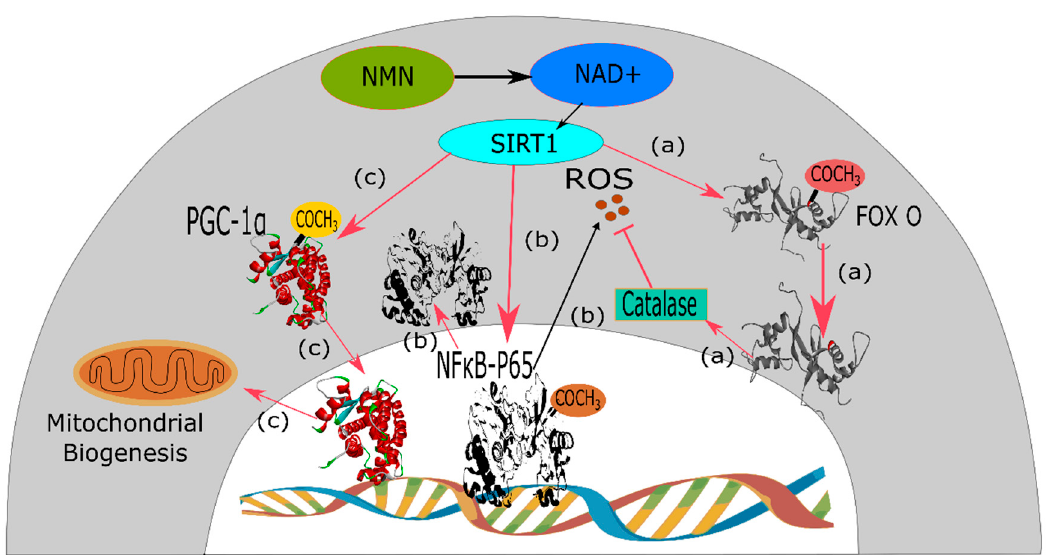
Figure 3. Mechanism of SIRT1 mediated pharmacological activities of NMN. NMN is converted to NAD+ intracellularly which performs physiological functions via SIRT1. ( a ) SIRT1 causes deacetylation of lysine residues of FOXO transcription factor that stimulates catalase enzyme to inhibit ROS and the chain reactions leading to ischemia-reperfusion injury. ( b ) In normal condition, p65 subunit of NF κ B transcription factor complex, in its acetylated form, expresses ROS which is also responsible for insulin resistance. SIRT1, due to its inherent deacetylation activity, deacetylates p65-NF κ B and thus inhibits production of ROS, which is responsible for the occurrence of type-2 diabetes mellitus. ( c ) SIRT1 also deacetylates protein PGC-1 α and stimulates the expression of proteins responsible for mitochondrial biogenesis, which can be used for the treatment of Alzheimer’s disease.